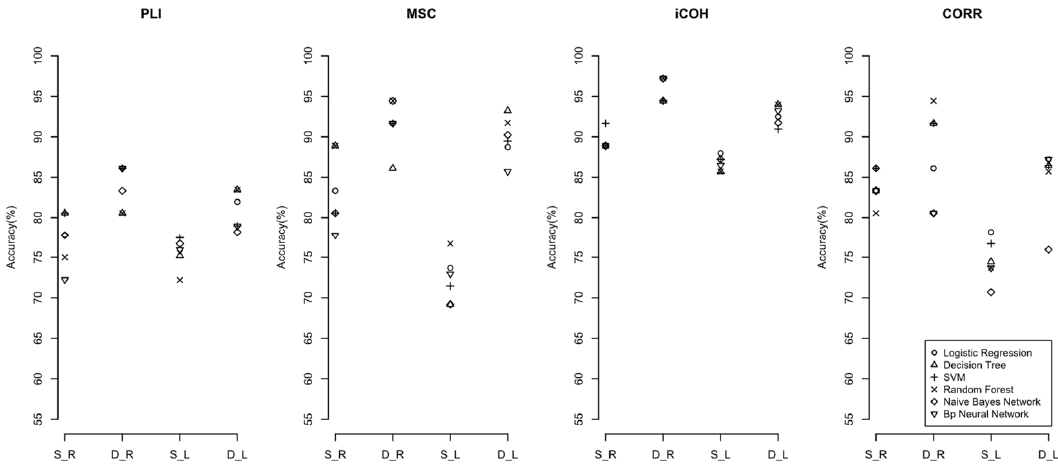
Figure 6. The accuracy of machine learning classifier with significant features under the beta-frequency band. (S: static network; D: dynamic network; L: split segment EEG signals dataset; R: original sequence EEG signals dataset; PLI: phase delay index; MSC: amplitude squared coherence; iCOH: coherence function Imaginary part; CORR: Pearson correlation coefficient).